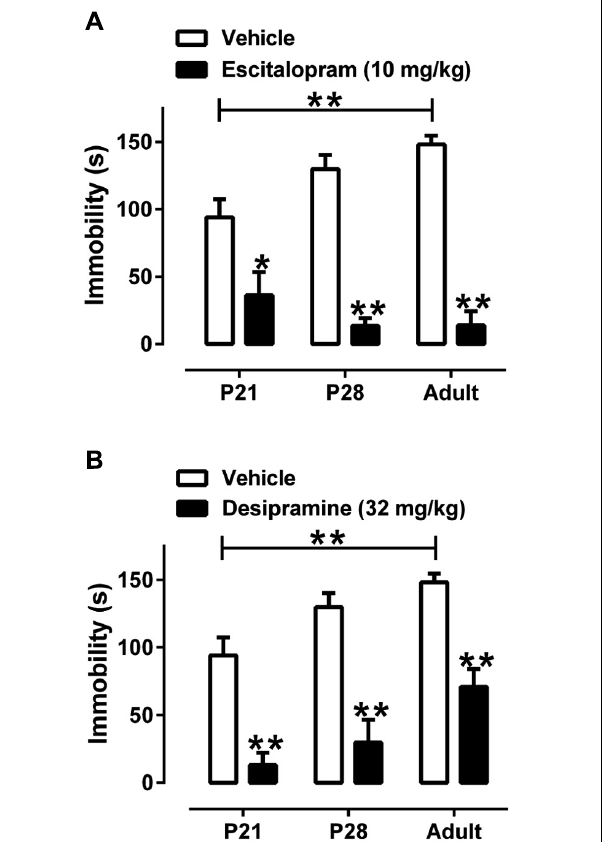
FIGURE 2 | Effect of escitalopram and DMI to reduce time spent immobile in theTST in male juvenile, adolescent, and adult mice. (A) Escitalopram (10 mg/kg, sc) significantly reduced immobility time in all age groups.There was a significant interaction between age and treatment revealing that escitalopram is less effective in reducing immobility time in P21 mice, compared with P28 or adult mice. (B) DMI (32 mg/kg, ip) significantly reduced immobility time in all age groups. Sample sizes were as follows: P21, n = 38 (20 saline, 8 escitalopram, 10 DMI); P28, n = 37 (20 saline, 8 escitalopram, 8 DMI); adult mice n = 39 (20 saline, 10 escitalopram, 9 DMI).There was no main effect of route of saline administration, so saline data were collapsed with age and drug as the only factors; two-way ANOVA withTukey’s post hoc tests, *P <